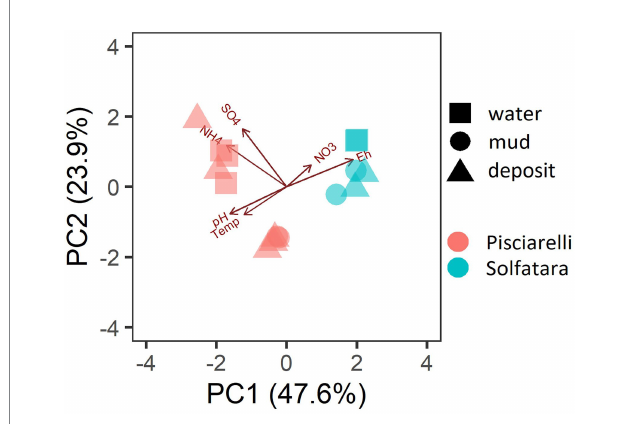
FIGURE 2 Biplot based on Principal Component Analysis (PCA) using temperature, pH, Eh, water-soluble anions and cations. Variables that had values below detection limit in most samples (F − , Cl − , and PO 43 − ) were excluded from